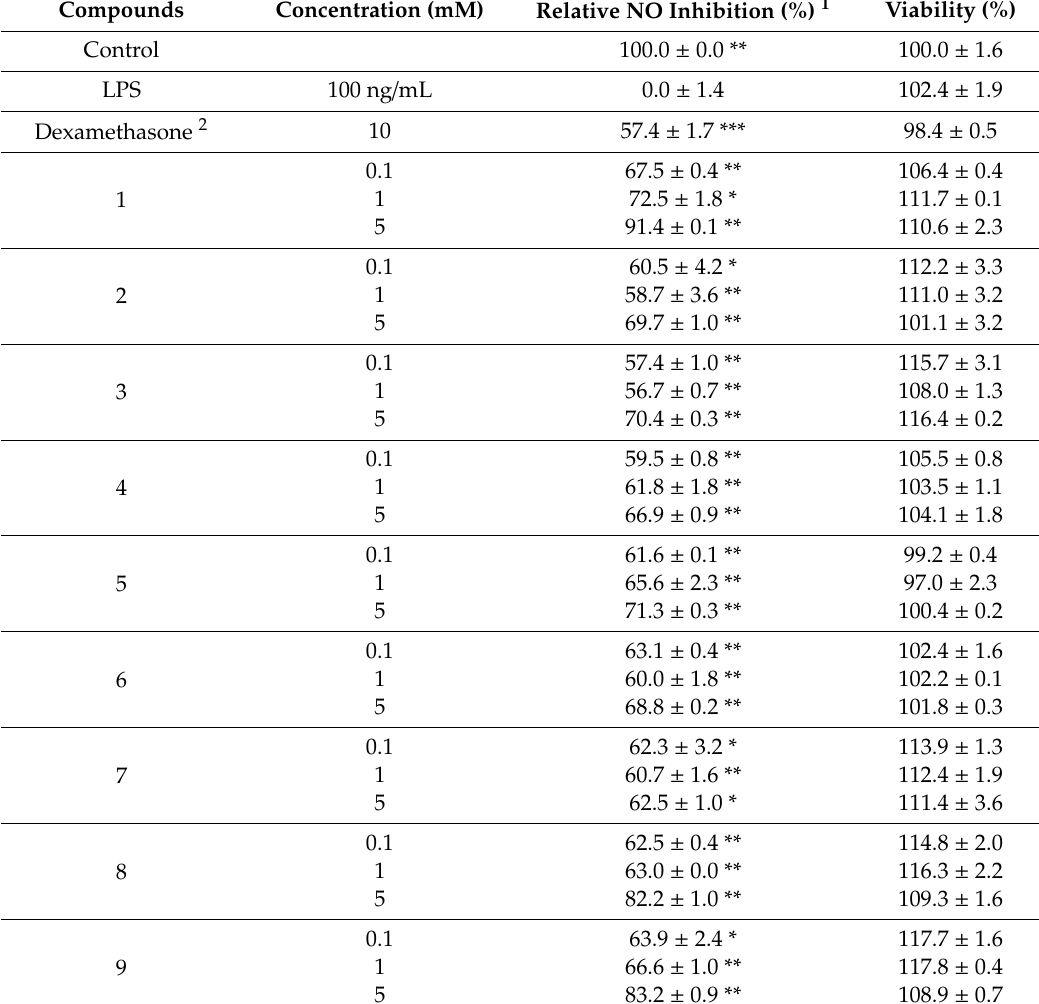
Table 2. E ff ect of isolated compounds on NO production in BV2 Table 2. Effect of isolated compounds on NO production in BV2 cells.